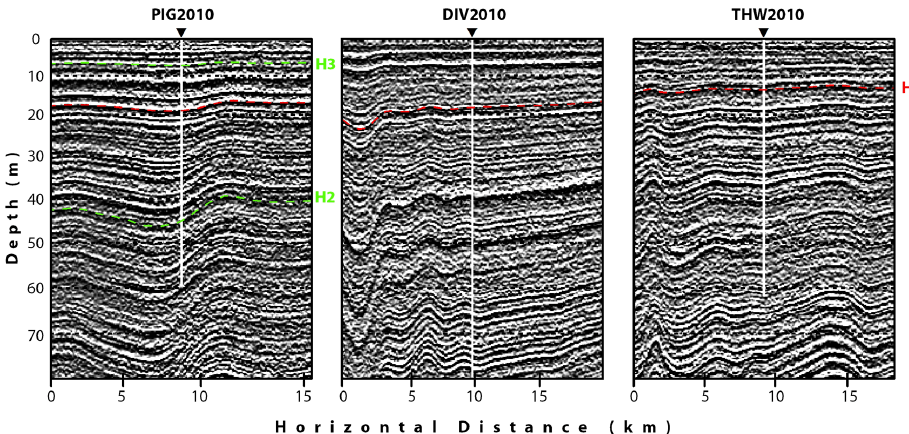
Figure 4. Echograms at each 2010 core site and the tracked H1 horizon. From left to right, we display echograms from the PIG2010, DIV2010, and THW2010 sites along with H1 mapped in dashed red and H2 and H3 in dashed green. The vertical white line shows the location closest to each core, which extends from the surface to the actual recovery